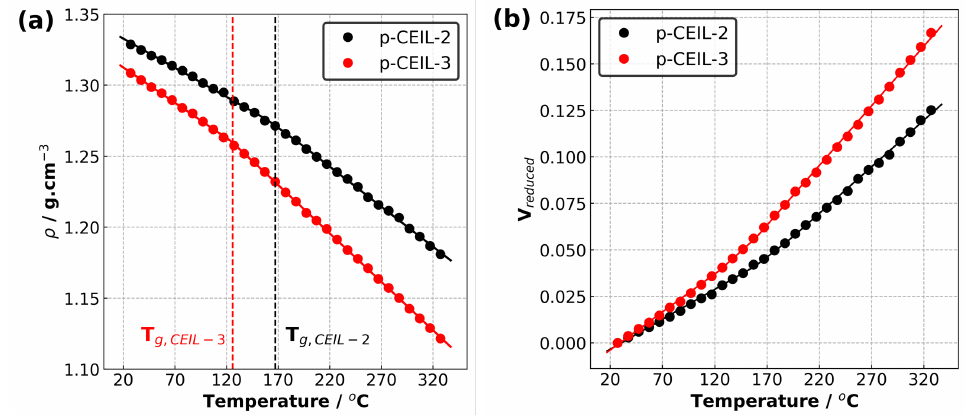
Figure 6. ( a ) Density versus temperature plot and ( b ) reduced volume versus temperature plot for p-CEIL-2 and p-CEIL-3 obtained using isobaric–isothermal molecular dynamics